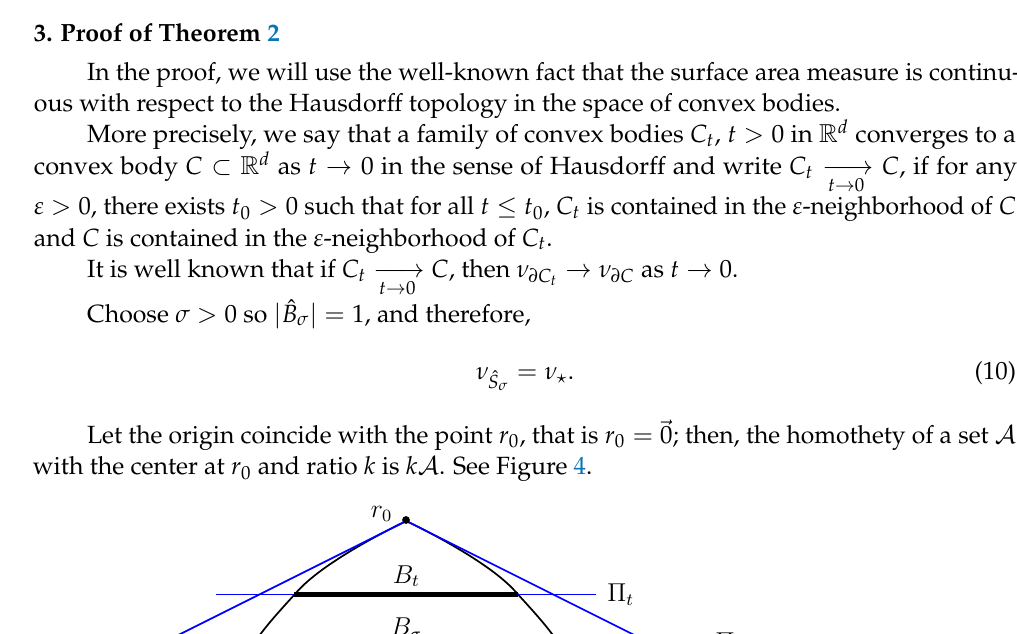
and Π , and the sets B t σ